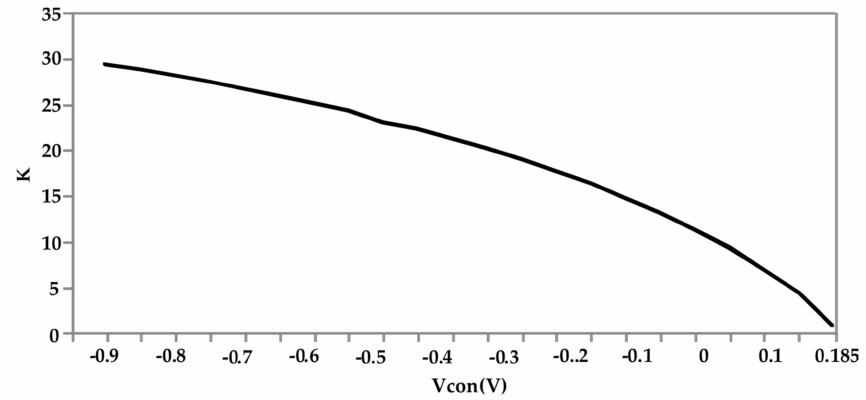
Figure 7. Variation of K as a function of V con for CVCII 2 +